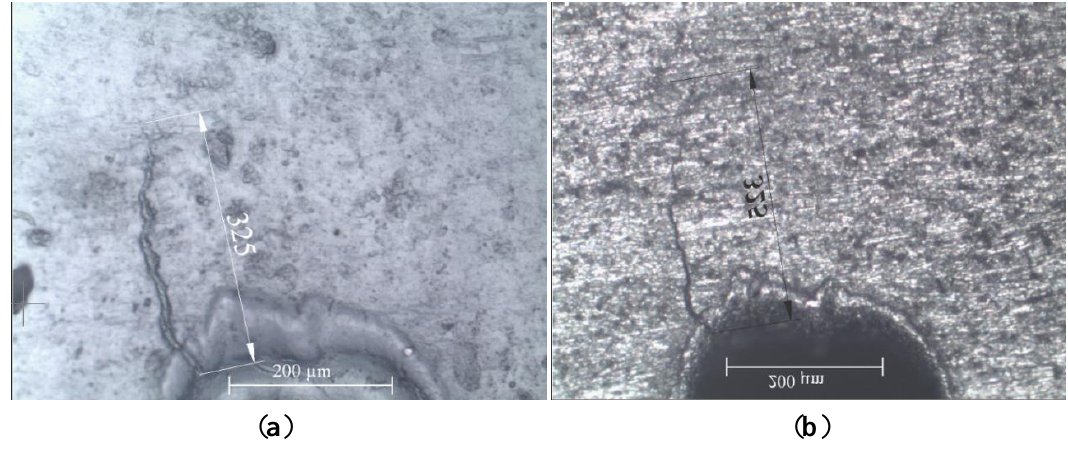
Figure 7. ( a ) Surface replica; and ( b ) microscope observation of the sample in the same area (mirror